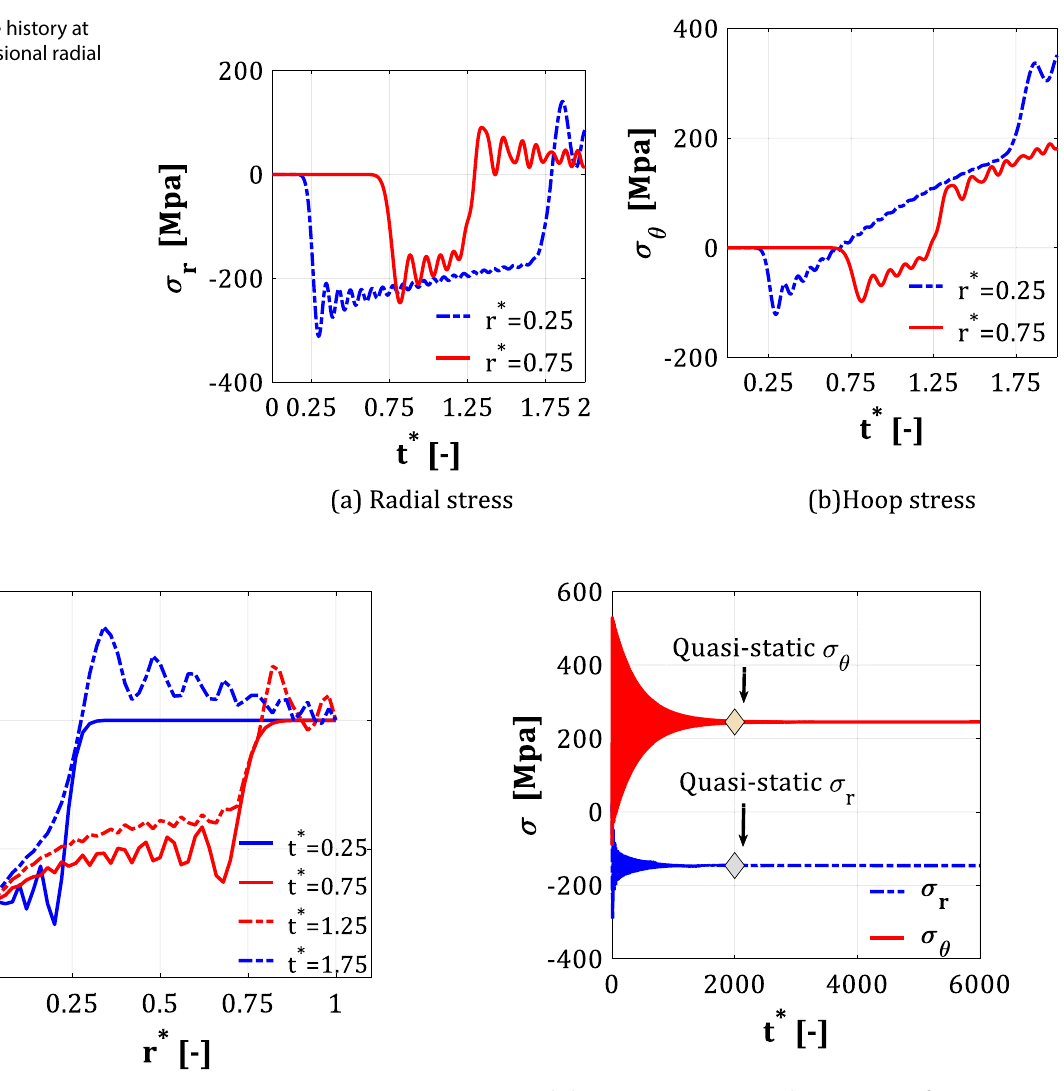
Fig. 6 Radial stress attenuation-time history at specific